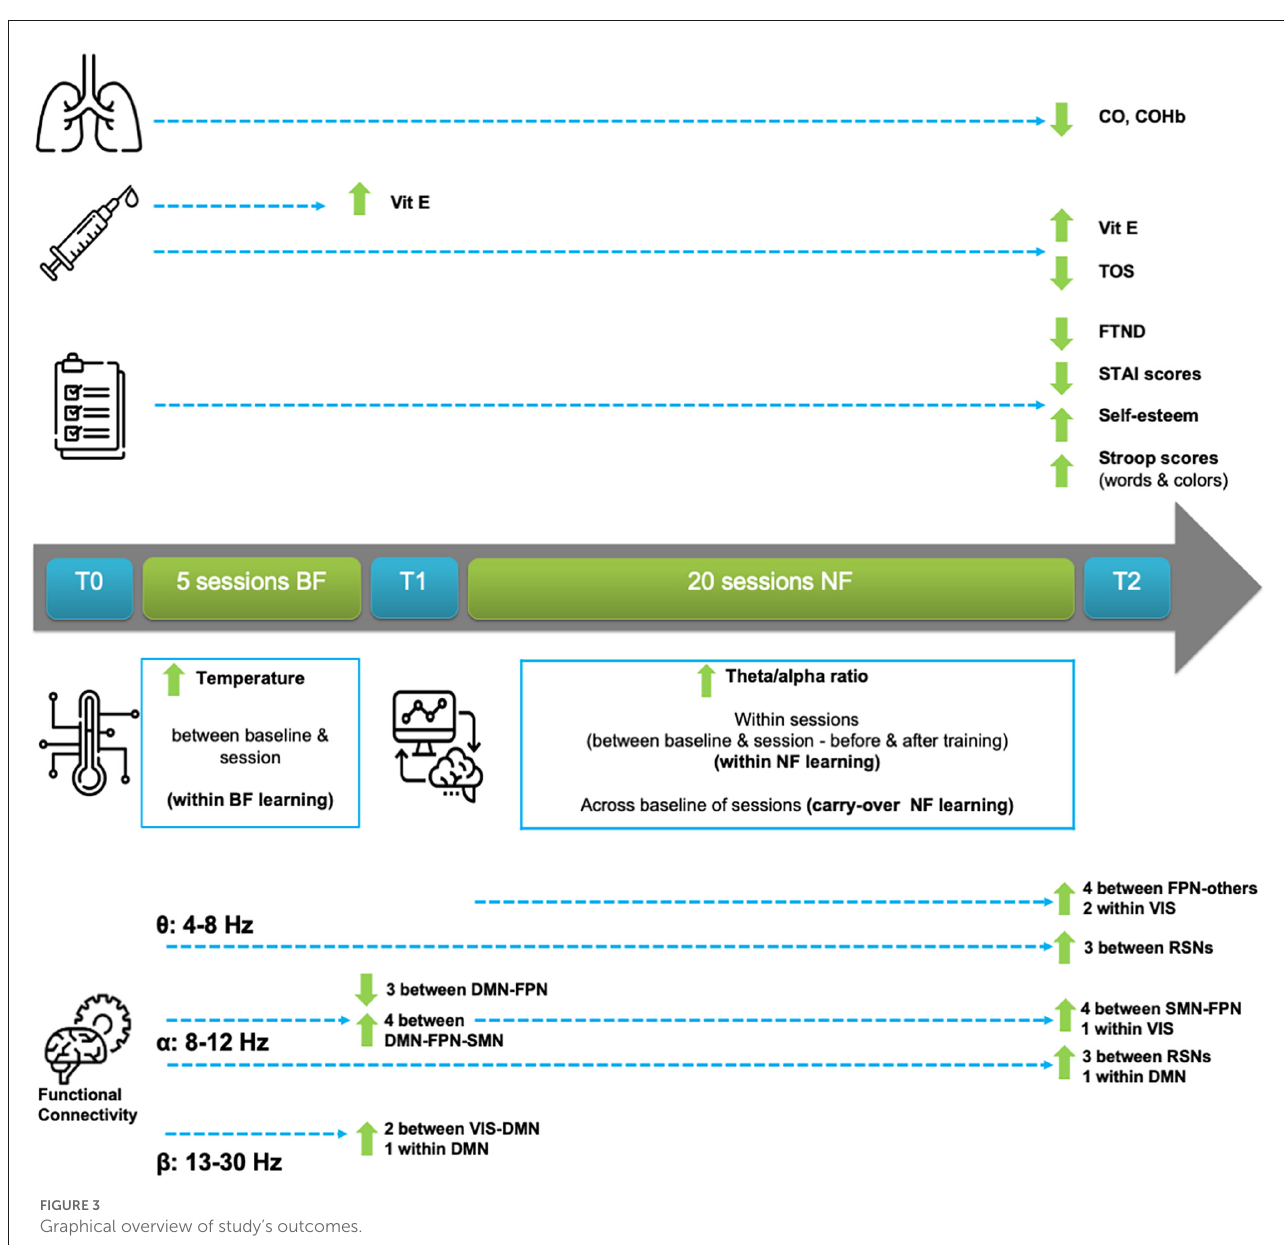
FIGURE3 Graphical overview of study’s